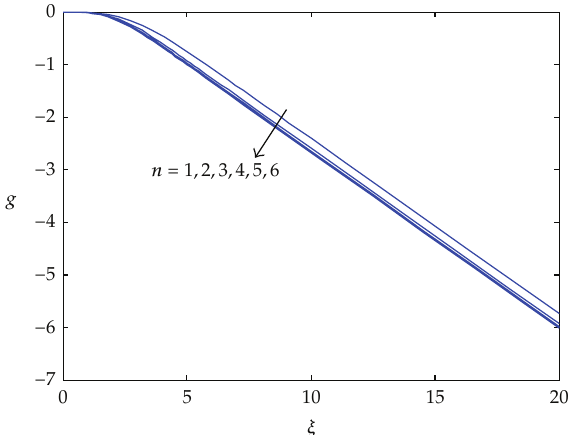
Figure 6: E ff ect of power index n on the similarity function g related to the y component of velocity (cid:7) ε 1 (cid:5) 1, ε 2 (cid:5) 1 (cid:8)